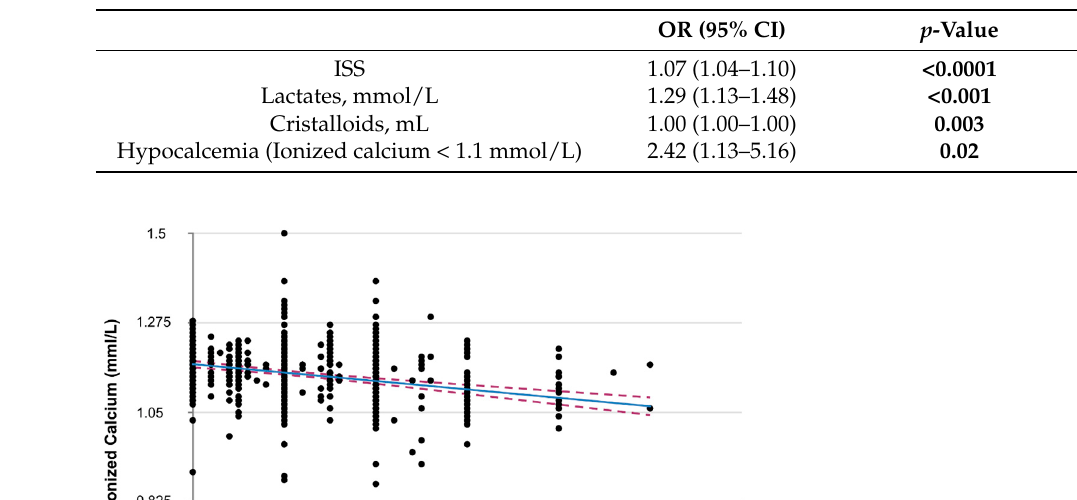
Table 3. Independent association with massive transfusion (logistic multivariate analysis) (bold: significant).